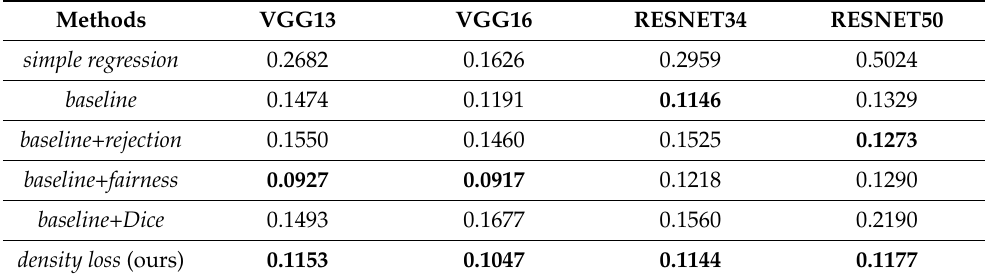
Table 1. Average distance (see Section 3.1) between true and predicted class distribution for different methods and backbones on CIFAR10 . The two best results are in bold.